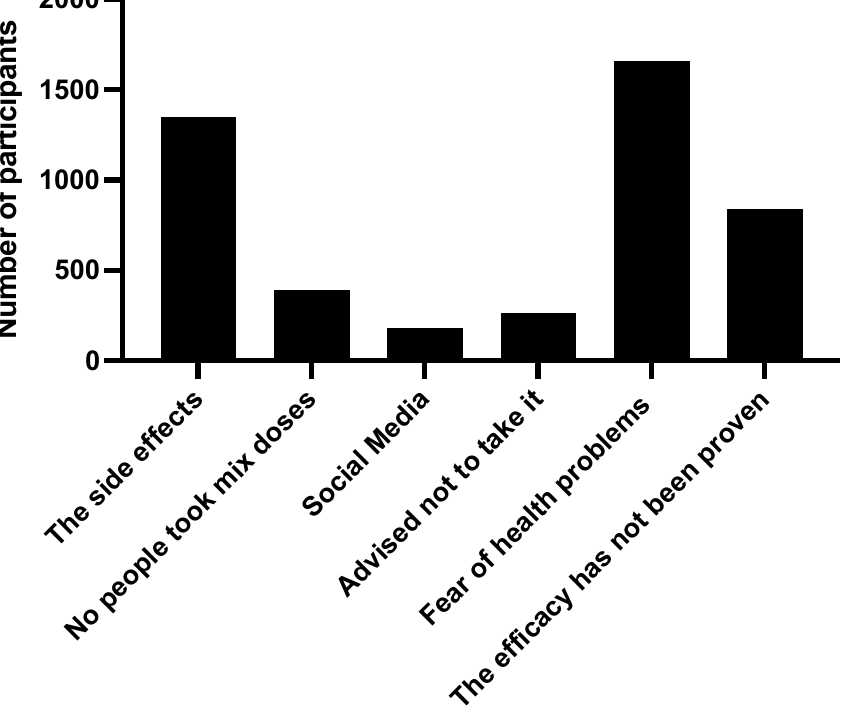
Figure 1. Perception of using various generic types of COVID-19 vaccines, the “mix-and-match” strategy, in Saudi Arabia. The X axis represents the percentage of the participants.